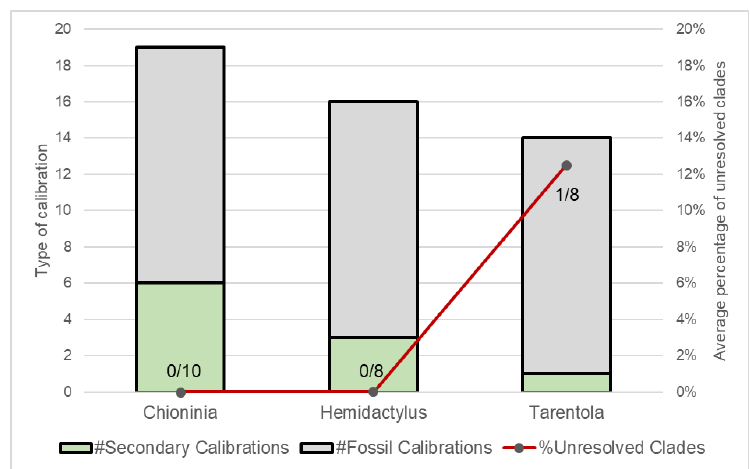
Figure 2. Number of studies (columns) and percentage of studied taxa (red line) within Macaronesian reptile lineages.